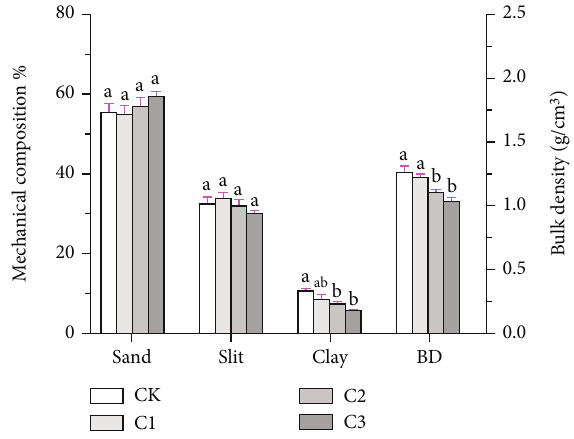
Figure 1: E ff ect of lime combined with fertilizer on soil texture and bulk density of rare earth mine